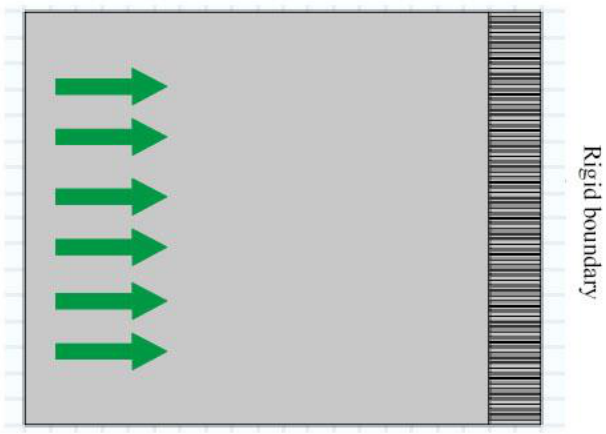
Figure 14. Reflection wave focusing model diagram.